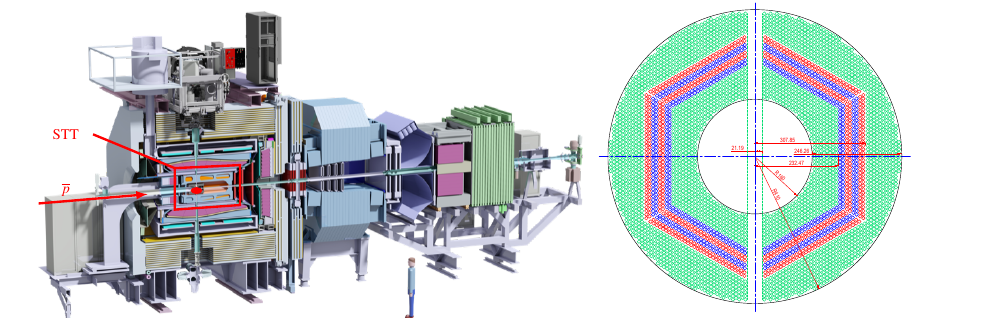
Figure 1: Left: The PANDA detector. Highlighted in red are the Straw Tube Tracker (STT), the direction of the incoming antiproton beam, and the interaction point. Right: A cross section of the STT. Tubes parallel to the beam direction are coloured green. Tubes inclined by ± 3 ◦ are coloured in blue and red,